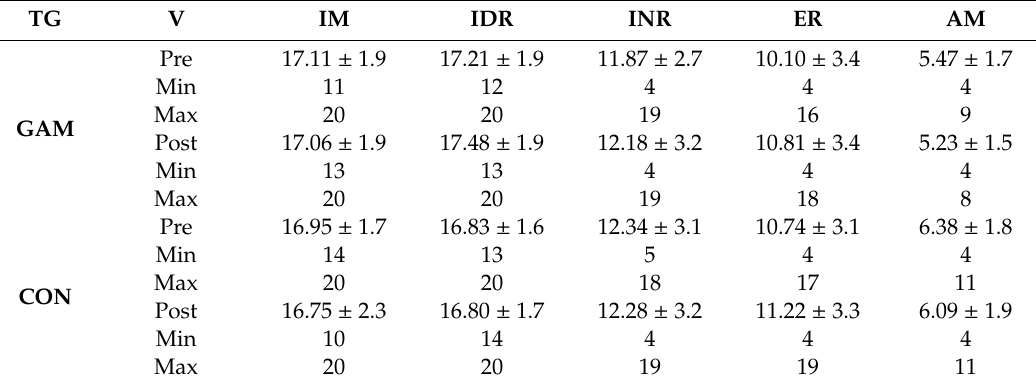
Table 6. Mean ± standard deviation for each educational group in motivational variables.